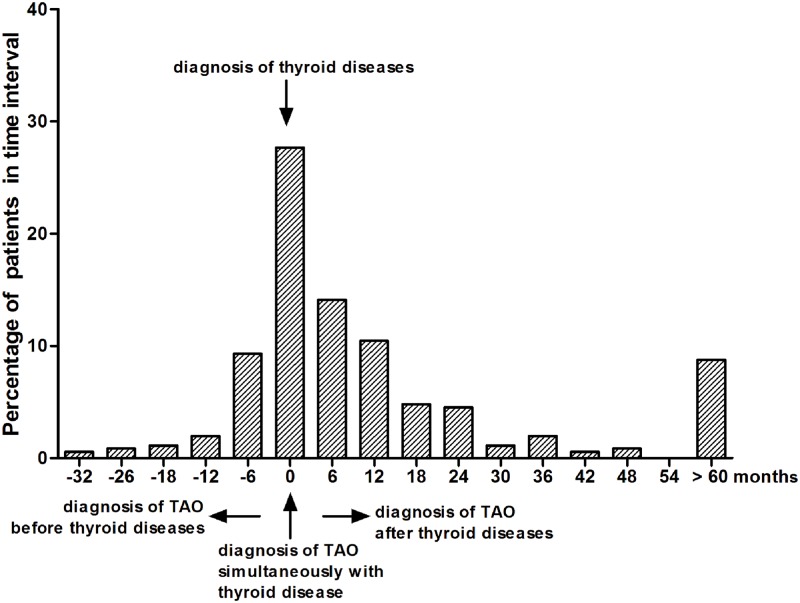
Temporal relationship between the diagnosis of TAO and thyroid dysfunction (hyperthyroidism or hypothyroidism).